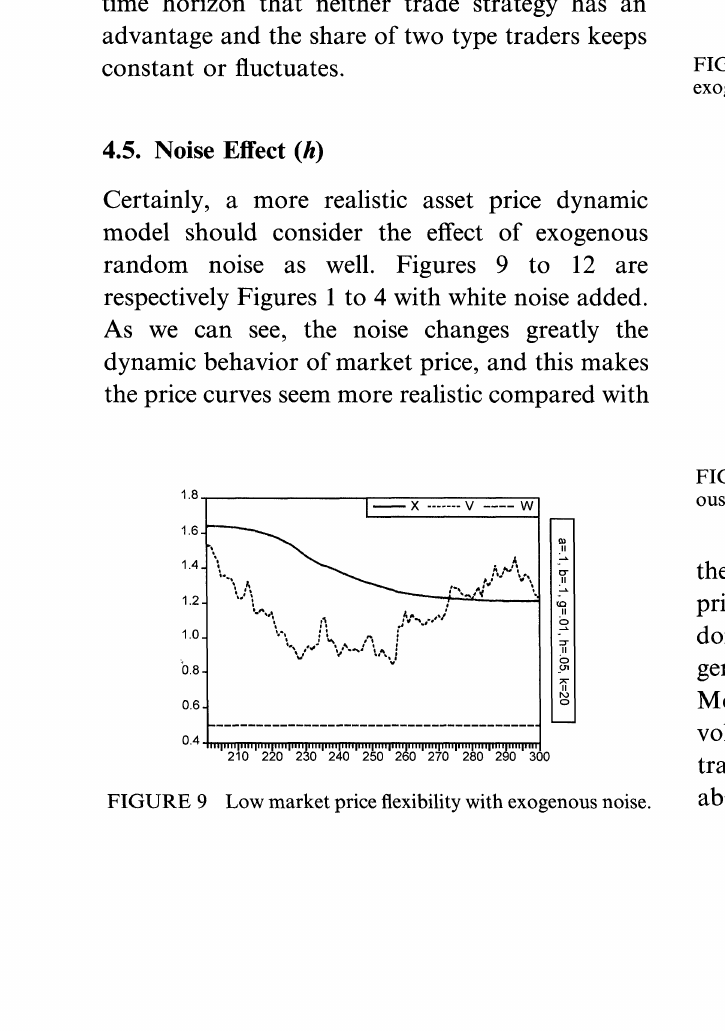
FIGURE 11 Moderately high market price flexibility with exogenous noise.